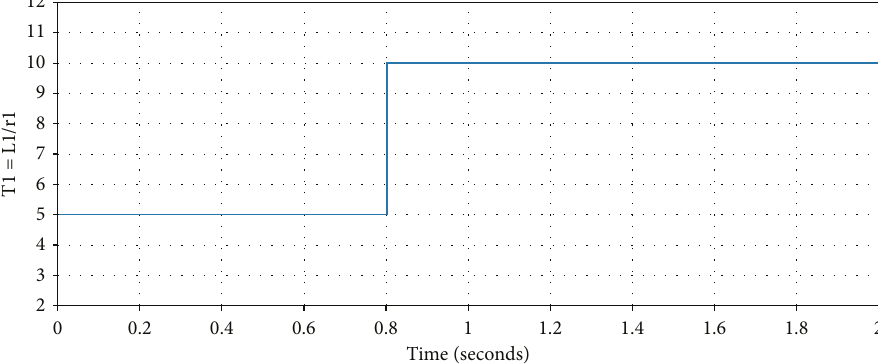
Figure 20: Time constant of the